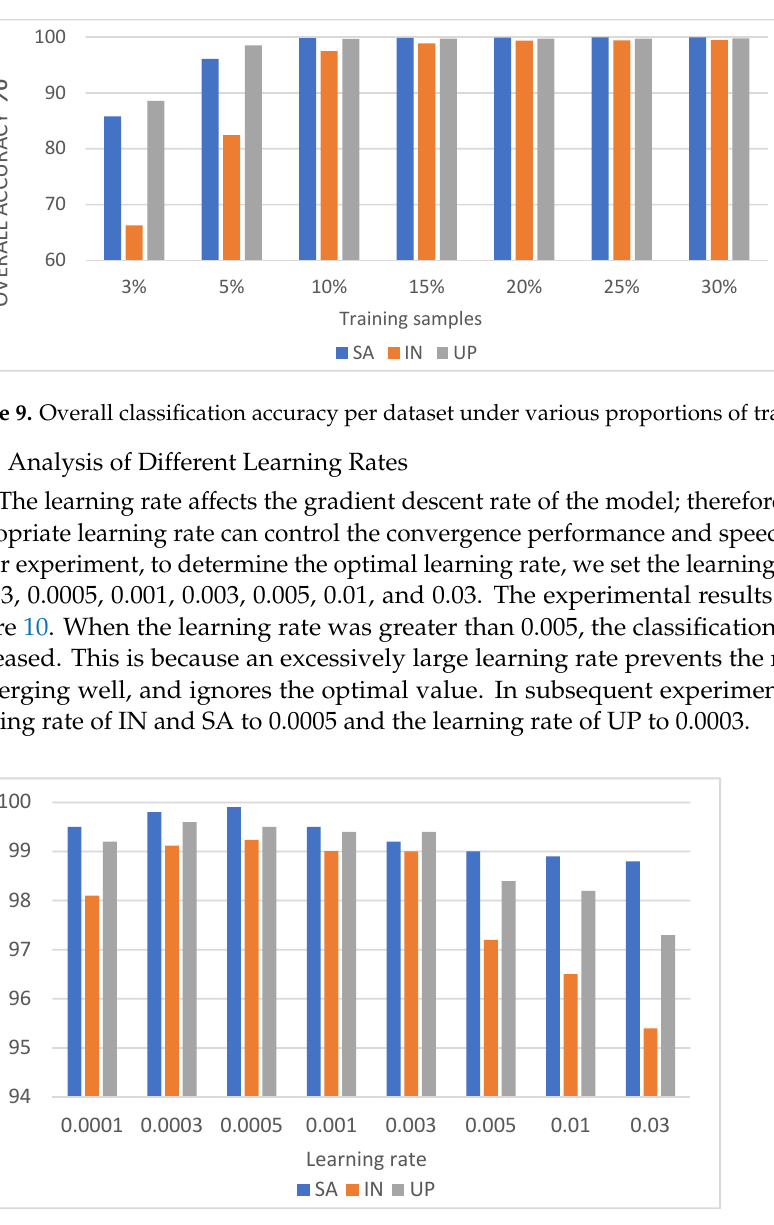
Figure 8. Overall classification accuracy per dataset under various patch sizes.